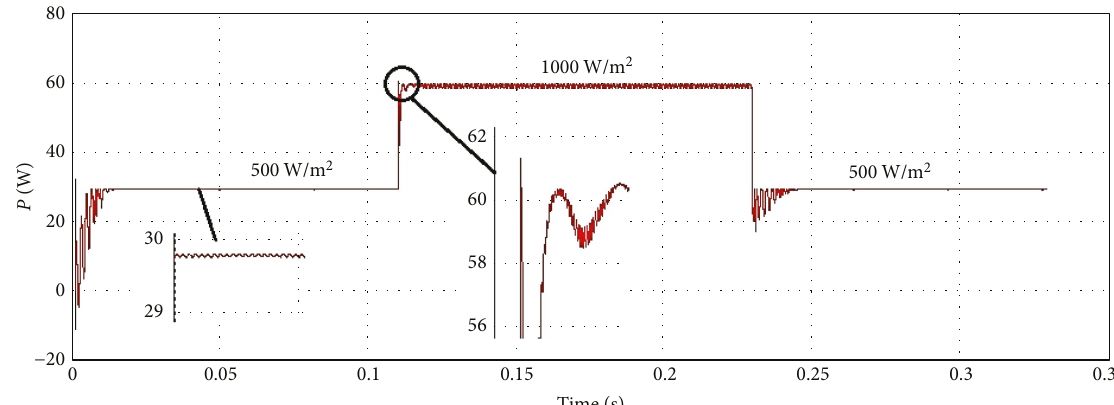
Figure 23: Test result of the modi fi ed INC